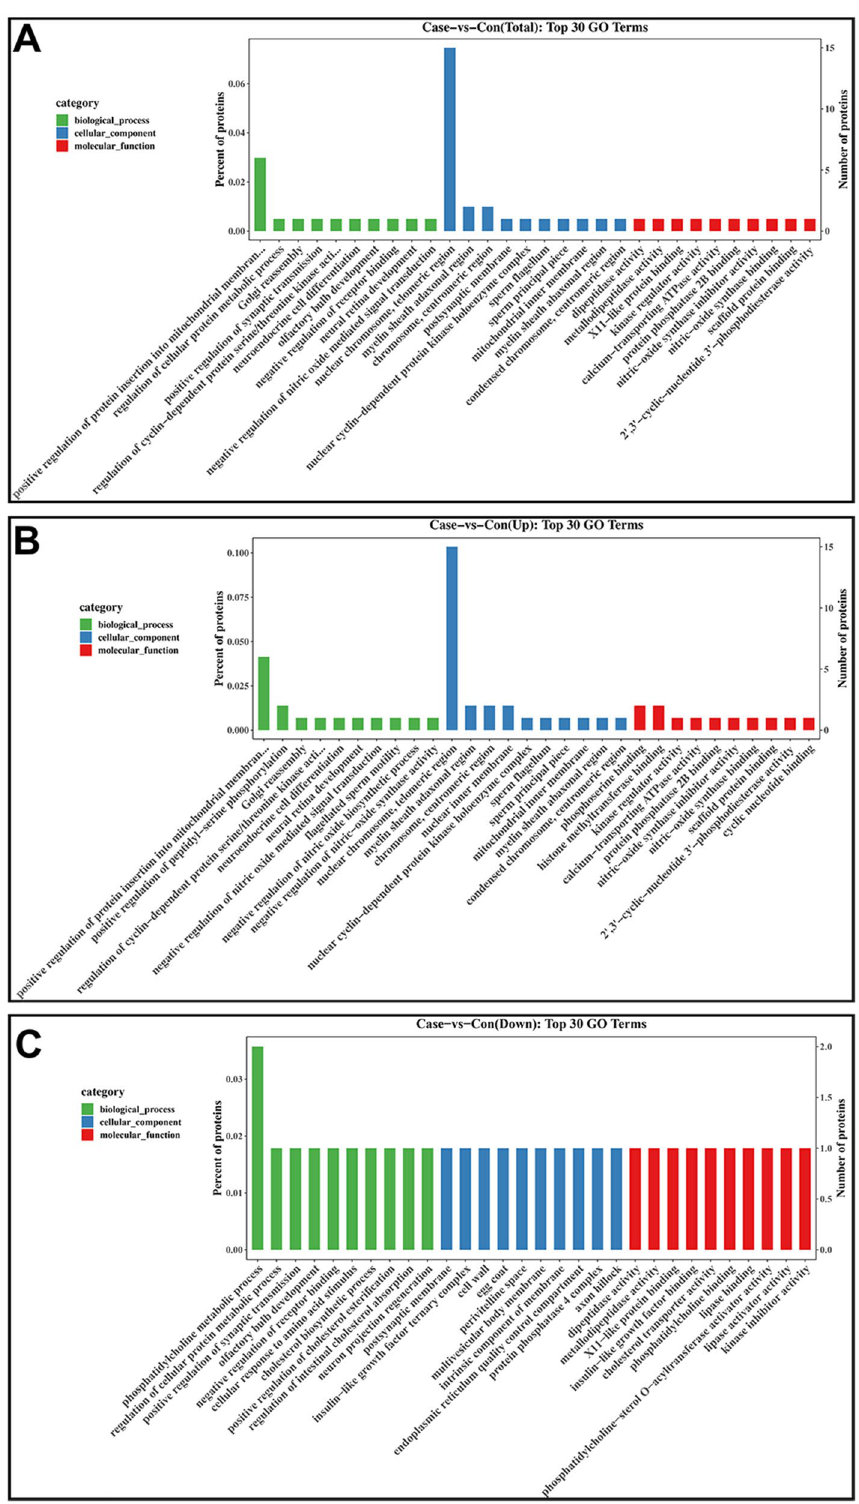
Figure 4. Gene ontology function enrichment analysis of the differentially expressed proteins (DEPs). Top 30 enriched terms of the ( A ) all DEPs, ( B ) upregulated DEPs, and ( C ) downregulated